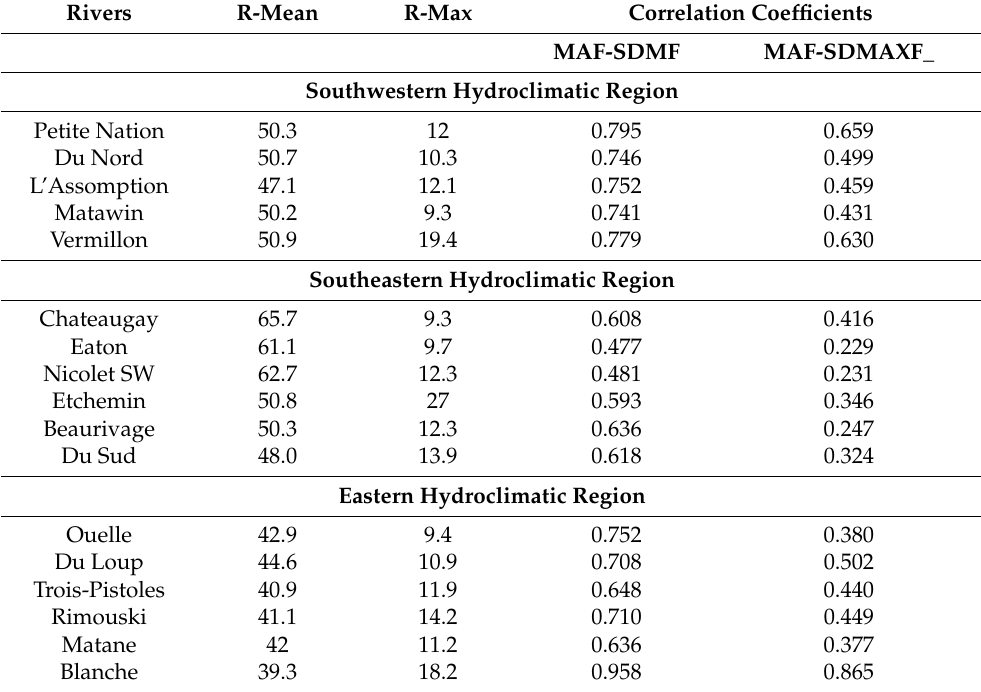
Table 4. Mean values of ratios (%) calculated between mean annual flows and spring mean and maximum daily flows from 1930 to